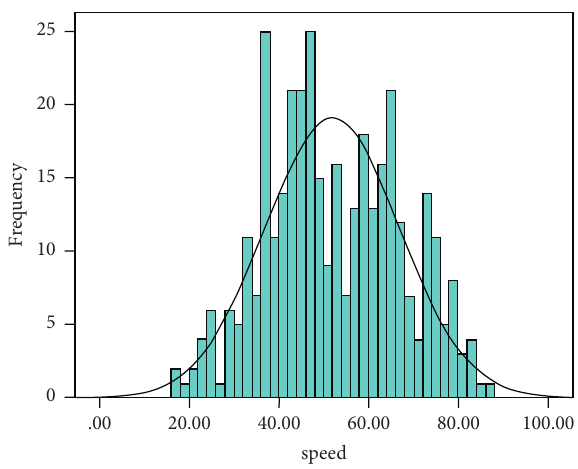
Figure 5: Histogram of gathered speed for normality test. Table 2: Linear regression model, the effect of independent variables on the dependent variable separately.